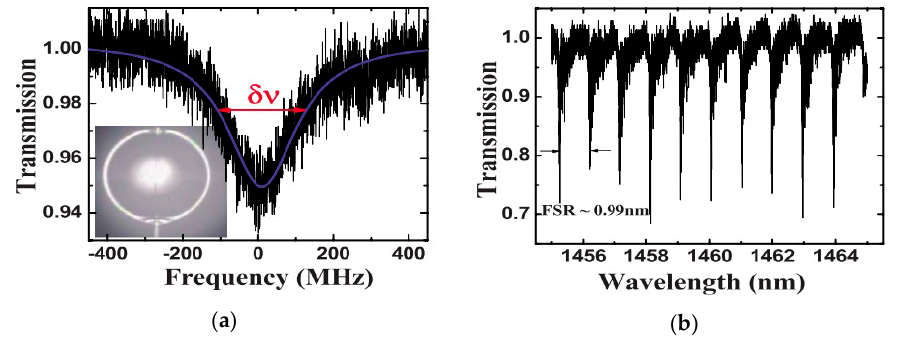
Figure 1. ( a ) Transmission spectra of the whispering gallery mode (WGM) resonance at λ = 1446.7 nm; ( b ) transmission spectrum of the polydimethylsiloxane (PDMS) microsphere in the 1460 nm band. [Reprinted/Adapted] with permission from ref [23], [AIP].